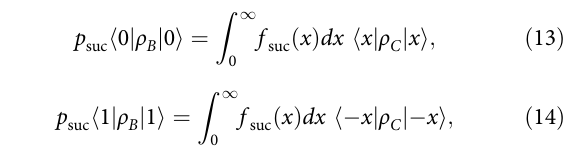
and Bob then run the protocol described in Box 1. Upon successful veri fi cation, the protocol generates a shared fi nal key of length